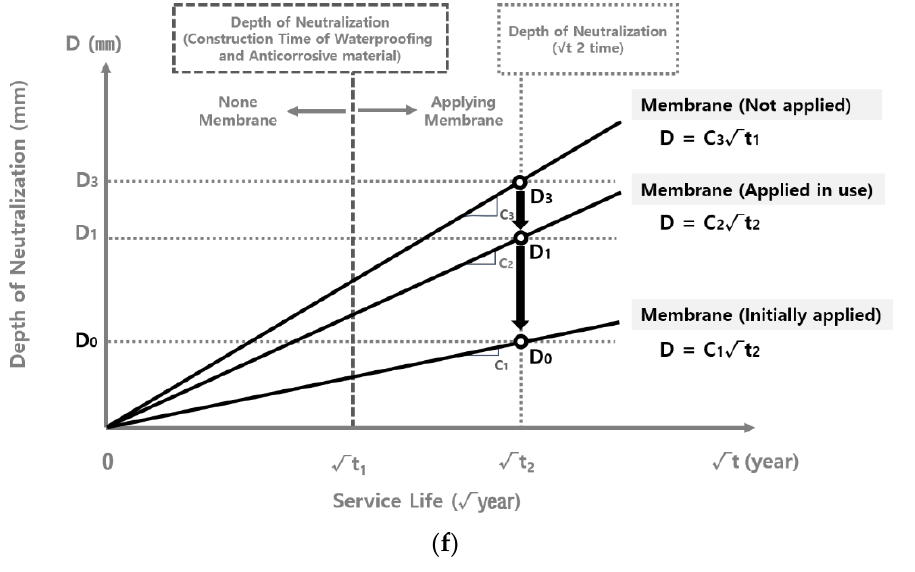
Figure 8. Carbonation depth distribution at the inner wall of water reservoirs (waterproof- ing/anticorrosive method applied after 15 years of service life): ( a ) Carbonation depth at the initial stage of application; ( b ) Derivation of D 1 with a graph of application during public service; ( c ) Derivation of D 2 with parallel translation of a graph of application at the initial stage of public service; ( d ) Derivation of C 3 at t 1 with D 2 ; ( e ) Derivation of D 3 at t 2 through the extension of the derived line; ( f ) Comparison according to the duration of the waterproofing/anticorrosive method application.